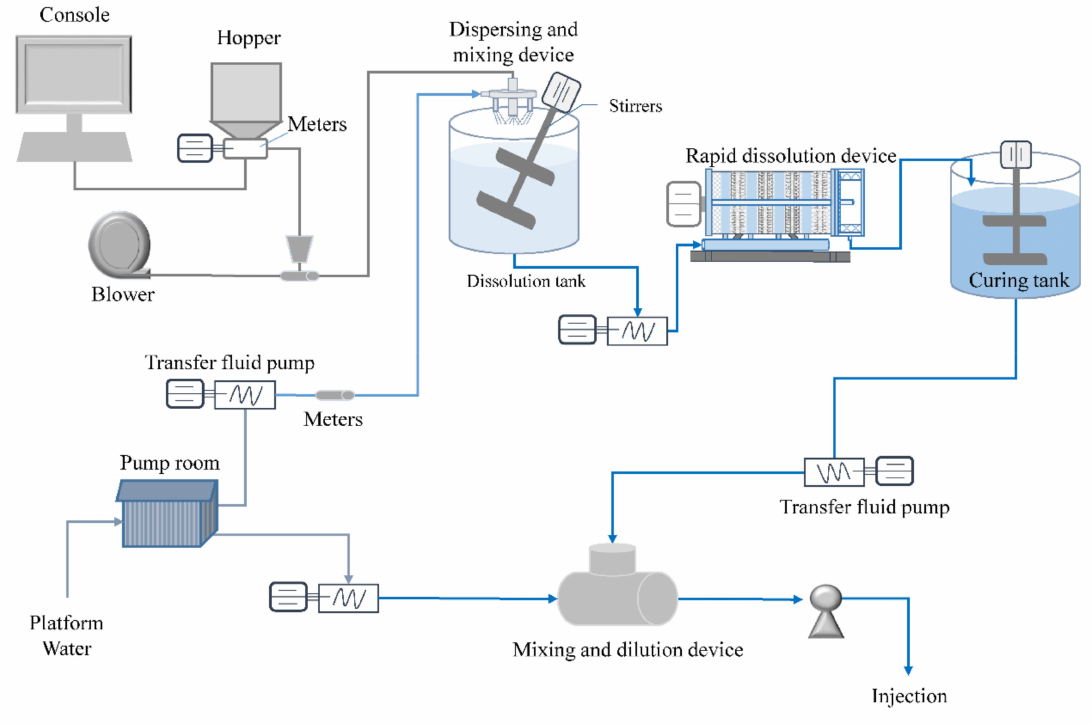
Figure 13. Polymer dispensing process diagram. The polymer AP-P4 solution viscosity was measured at 5 min intervals using beakers sampled at the outlet of the forced stretch fast dissolution device and the outlet of the supergravity fast dissolution device, respectively, and the test results are shown in Figure